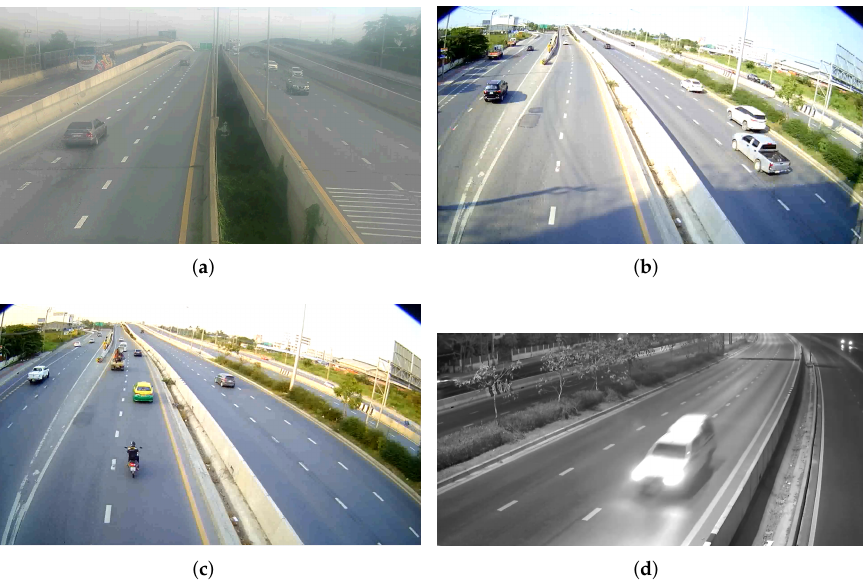
Figure 8. Sample image frames of four videos used for the experimentation on different qualities of streams. ( a ) Vid 1 (noisy video). ( b ) Vid 2 (high light intensity at 3 p.m.). ( c ) Vid 3 (proper light intensity at 5 p.m.). ( d ) Vid 4 (nighttime at 3